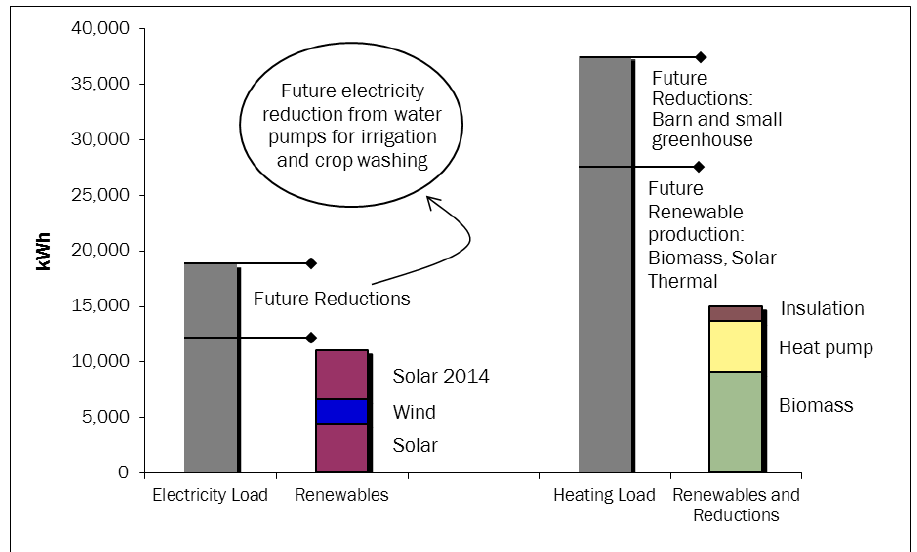
Figure 1. Farm Present and Future Energy Demand and